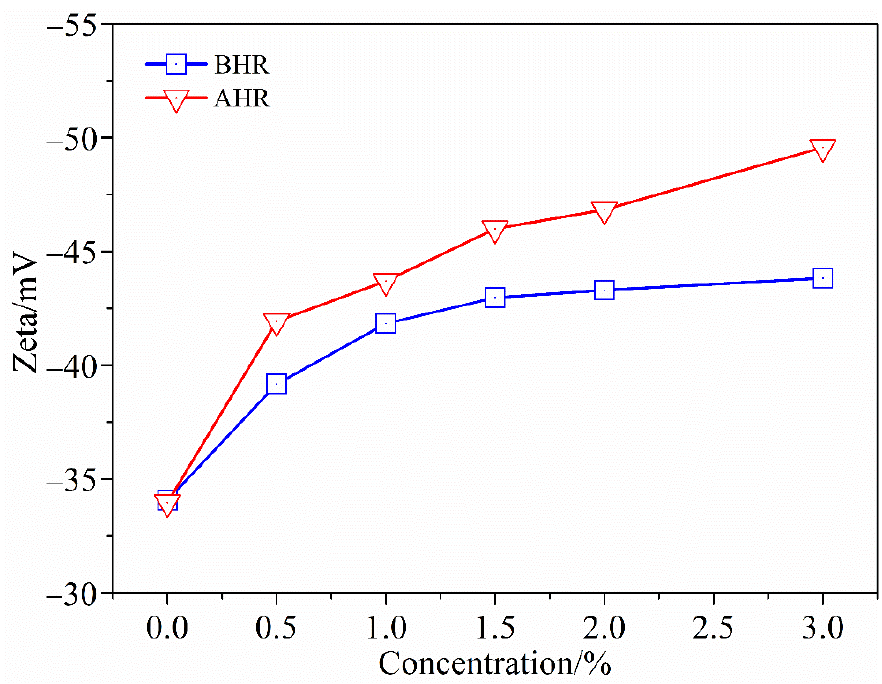
Figure 7. Changes of the Zeta potential of the drilling fluid before and after aging under different concentrations.